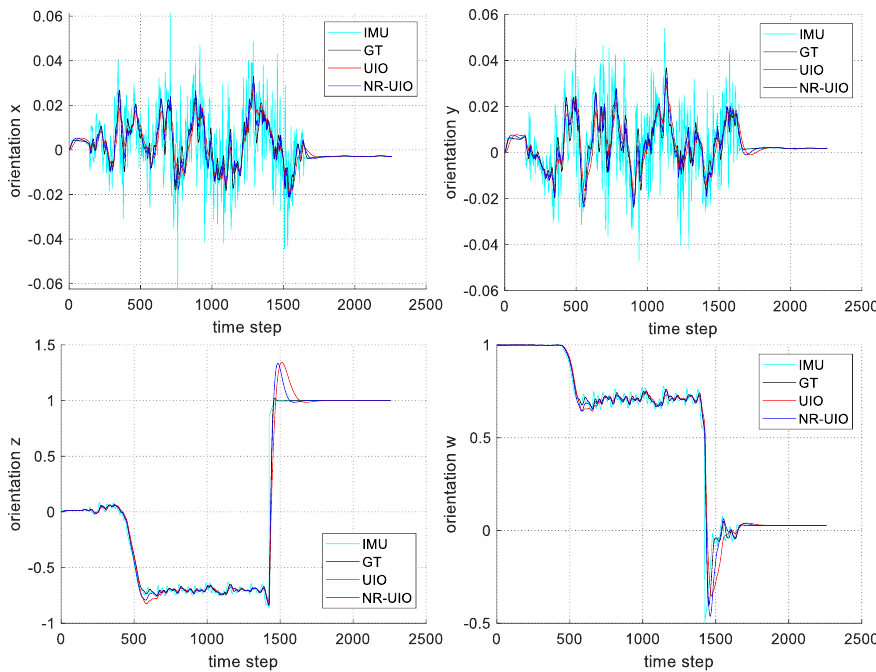
Figure 8. The comparison of the estimated orientation quaternion components ( x , y , z , and w ) with groundtruth.